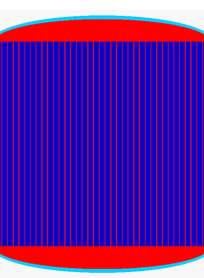
Figure 3. Schematic diagram of 2MW MSR system Table 2. Verification of static burnup simulation results with ORIEGNS \